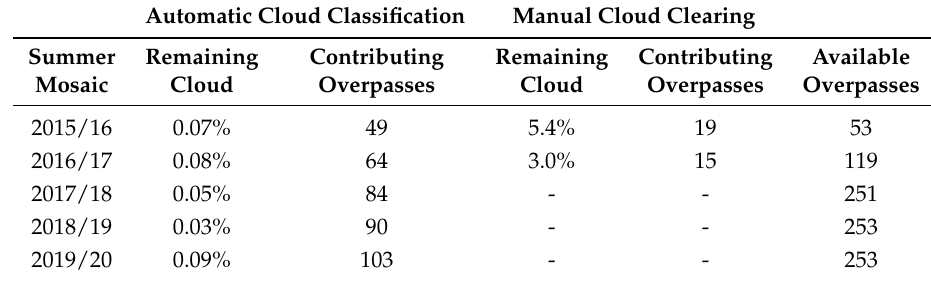
Figure 4. Automatically generated Sentinel-2 summer mosaics of New Zealand. All mosaics are better than 99.9% cloud-free. Table 1. Statistics for automated mosaics using both automated cloud/cloud-shadow classification and manual digitising of cloud/cloud shadow. The summer mosaic period is 4 months from November through